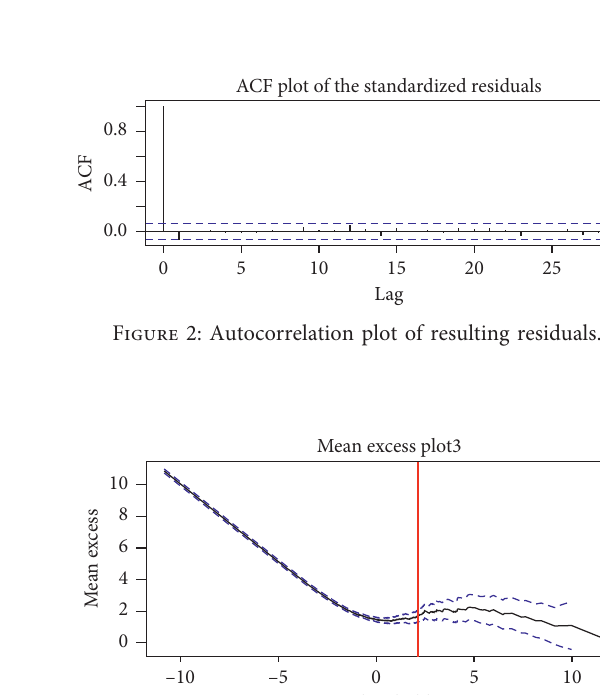
Figure 1: Sample path superimposed with median.